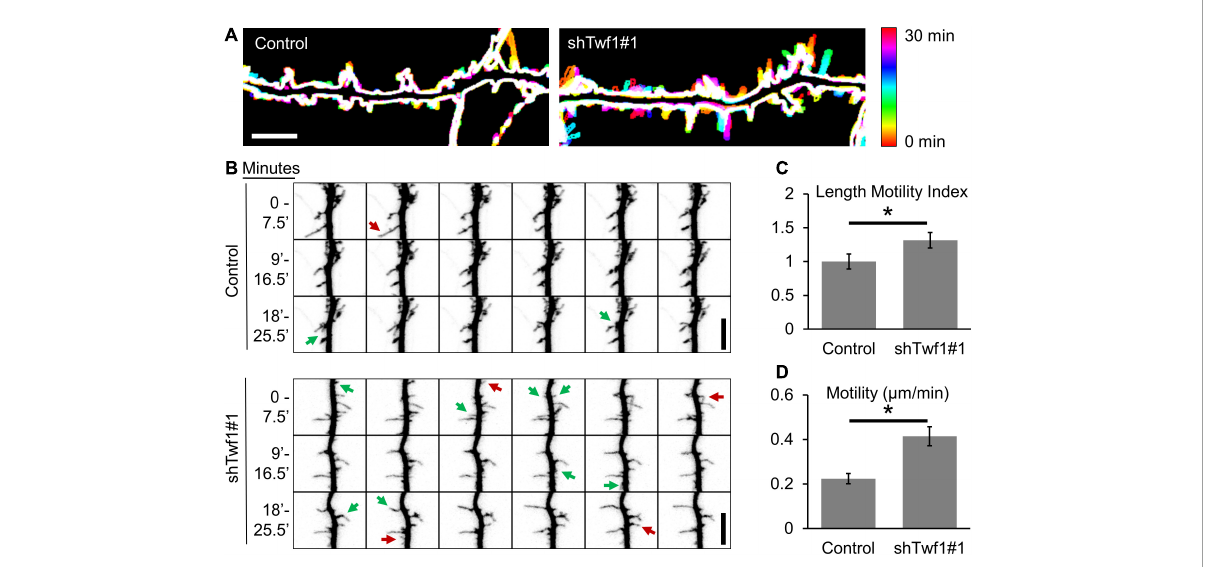
FIGURE4 Twinfilin-1 (Twf1) knockdown destabilizes dendritic protrusions. (A) 30-min time-lapse of DIV15 hippocampal neurons, transfected at DIV11 with either pSuper-mCherry (Control) or shTwf1#1 (which co-expresses mCherry). Temporally color-coded images show increased protrusion dynamics in Twf1 knockdown neurons relative to controls. (B) Montage of a time-lapse video highlighting growing (green arrows) and retracting (red arrows) dendritic protrusions. Quantification shows significantly increased rates of Length Motility Index (LMI) (C) and Motility (D) in Twf1 knockdown neurons ( N = 5 neurons; 8–15 protrusions/neuron). Scale bars, 5 µ m. Error bars represent SEM. * P < 0.05; Mann–Whitney